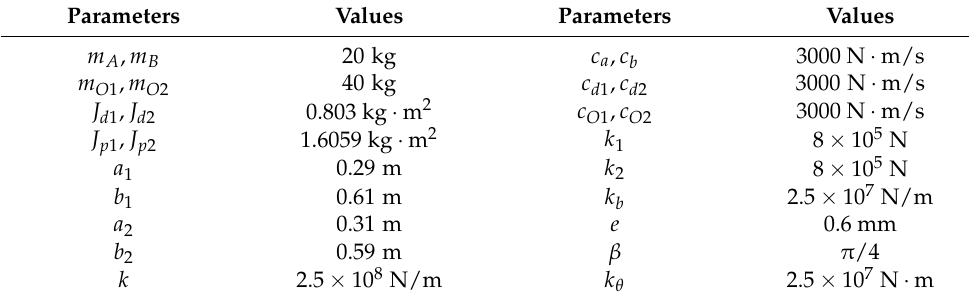
Table 1. Parameters of the rotor system.